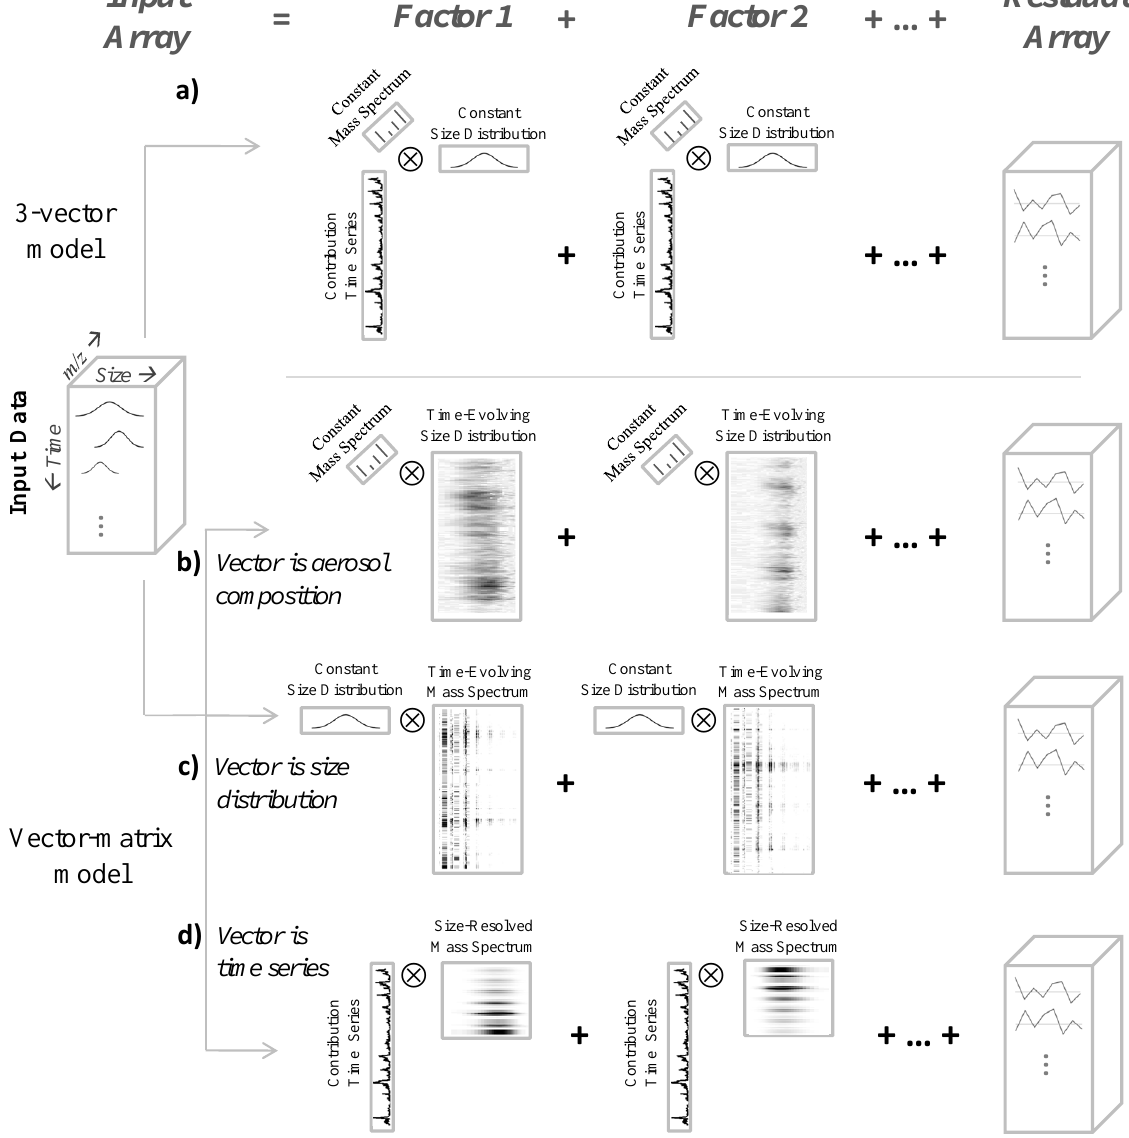
Fig. 1. Schematic representation of factorization methods of 3-D matrices. (a) In the 3-vector model, each factor is represented by three vectors (here a mass spectrum, a size distribution, and a time series of the contribution of the factor). (b) – (d) In the vector-matrix model, each factor is represented by one vector (representing one of the original array dimensions) and one matrix (representing the remaining array dimensions). The model can be arranged so that any of the original dimensions is represented by the vector: (b) the vector represents a mass spectrum, (c) the vector represents a size distribution; (d) the vector represents a time